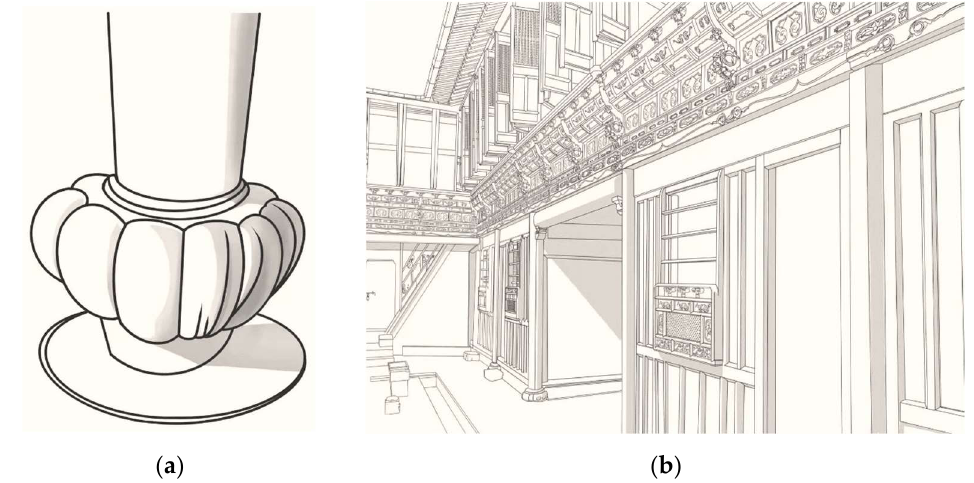
Figure 2. ( a ) Structure of stone plinth; ( b ) foyer and patio of Cheng’s Miyake Museum. Plinth Data Collection